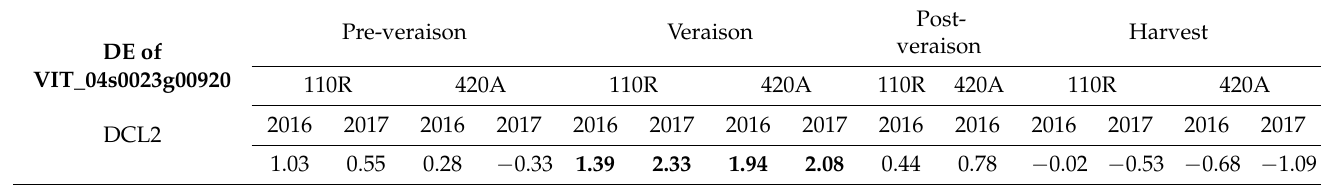
Table 1. Log fold change of VIT_04s0023g00920 which encodes for a dicer-like protein (DCL2). Bolded values indicate a significant difference (FDR adjusted p < 0.05). DEG = differential expression, 110R = Cabernet Sauvignon on rootstock 110R, 420A = Cabernet Sauvignon on rootstock 420A, PV = pre-veraison, V = veraison, PoV = post-veraison, and H = harvest.